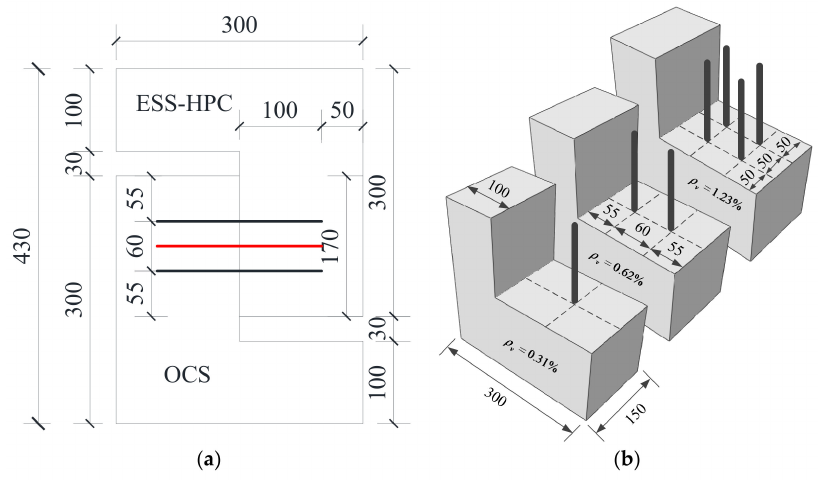
Figure 3. Steel shear dowels (unit: mm). ( a ) Elevation view; ( b ) vertical view.